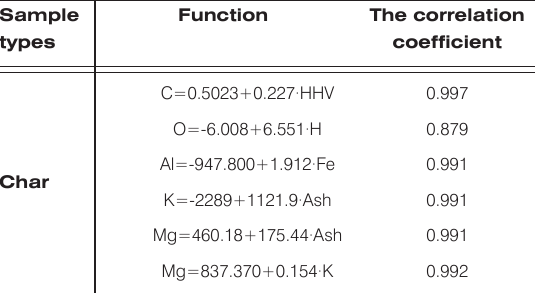
Table 3. Summary of the correlation function for the studied char